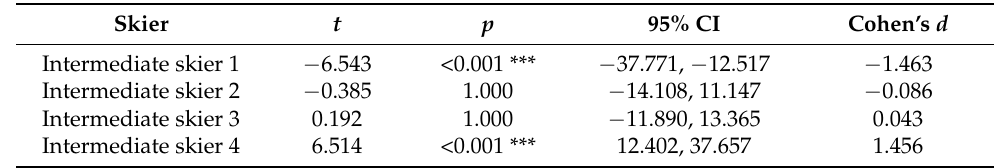
Figure 8. ( a ) Heel load ratio time-series data for each participant and ( b ) the mean heel load ratio. Blue and orange repre- sent the left and right turns, respectively. Statistical significance is indicated with *** p < 0.001. Table 3. Results of the post-hoc comparisons for mean heel load ratio. The expert skier was compared to each intermediate skier.